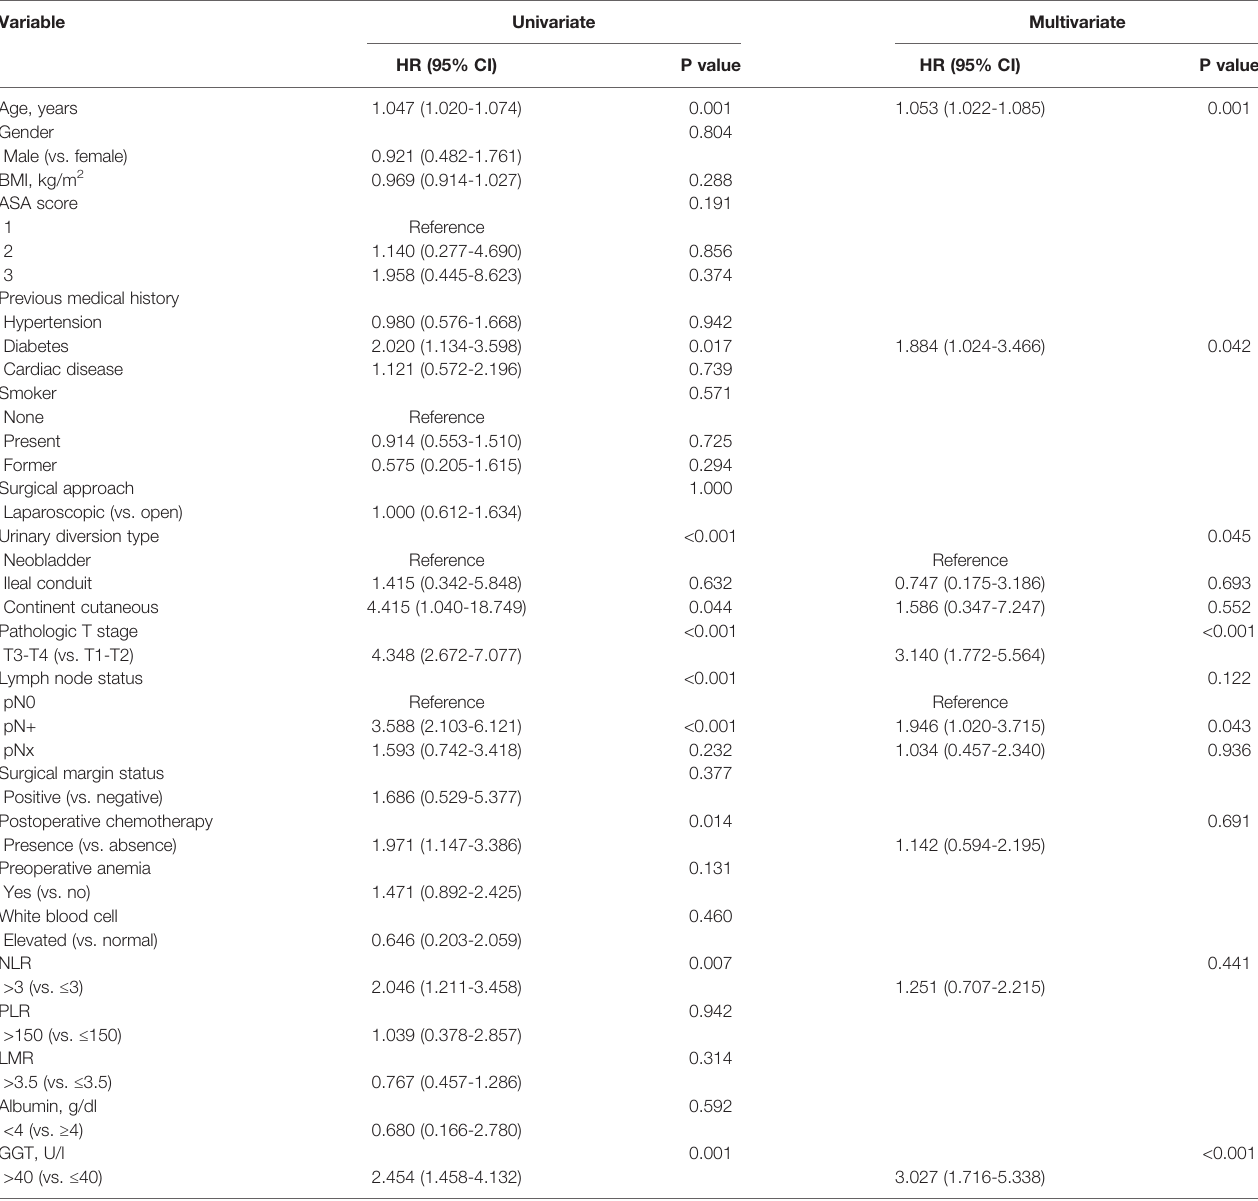
TABLE 2 | Univariate and multivariate analysis for variables predicting overall survival.